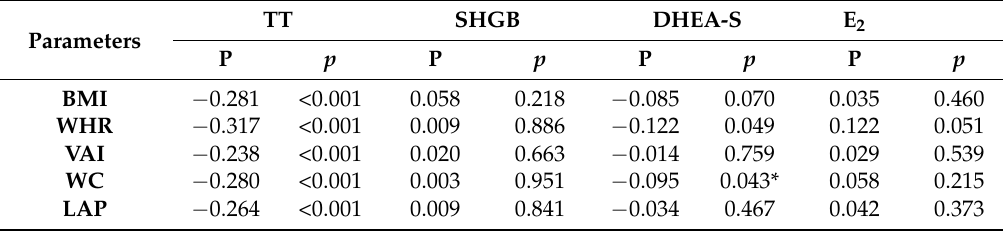
Table 3. Correlations between the concentrations of the selected hormones and the metabolic and anthropometric